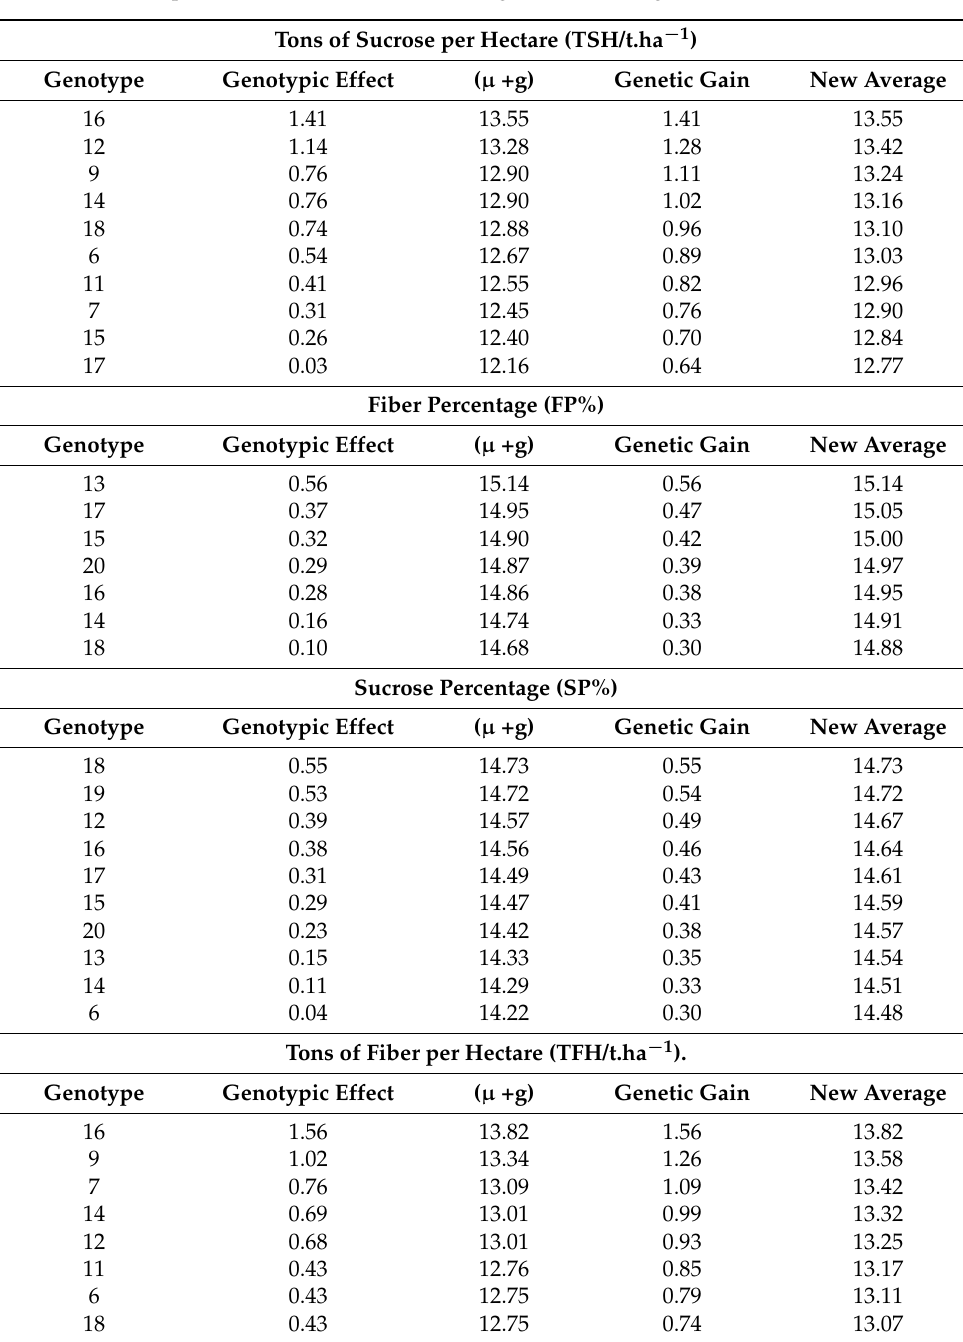
Table 4. Prediction of genetic gains for the traits tons of sucrose per hectare (TSH), fiber percentage (FP), sucrose percentage (SP), and tons of fiber per hectare (TFH) in the best sugarcane genotypes, evaluated in an experiment conducted in the five sugarcane microregions of the State of Pernambuco. Tons of Sucrose per Hectare (TSH/t.ha − 1